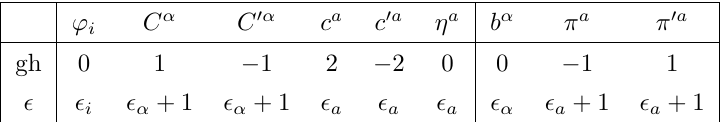
Table 3 . Ghost numbers and Grassmann parities of the various fields in the first-stage reducible case. Antifields have gh(Φ ∗ ) = − gh(Φ I ) − 1 and opposite parity, (cid:15) (Φ ∗ I